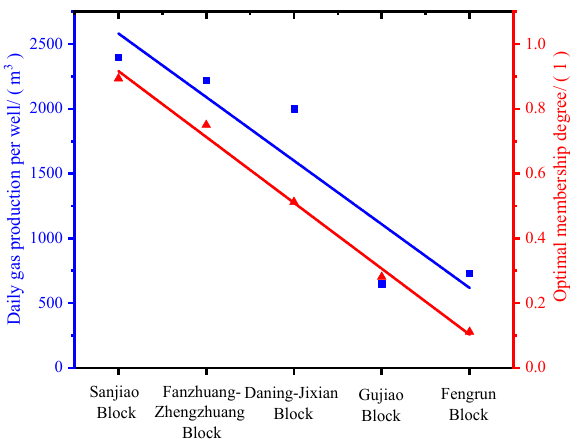
Figure 3. The trend chart of daily gas production per well and optimal membership degree in CBM blocks.